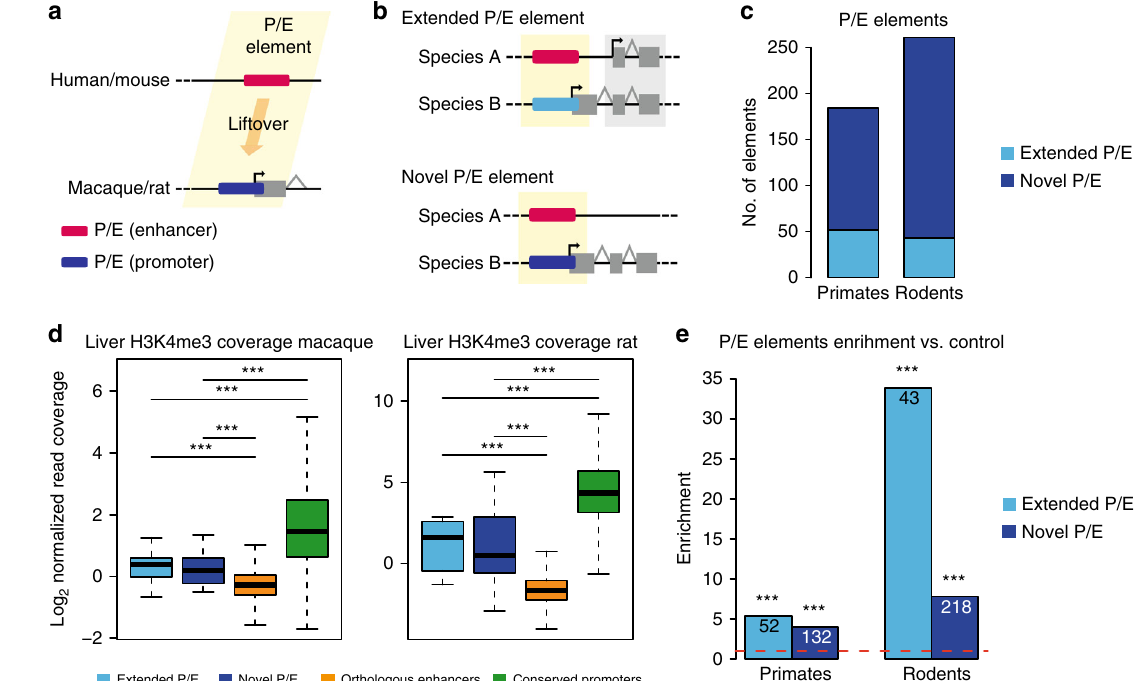
Fig. 1 Repurposing of regulatory elements in mammals. a Schematic representation of a P/E element in primates and rodents. b Types of P/E elements. c Total number of novel and extended P/E elements detected in primates and rodents. d Macaque and rat H3K4me3 ChIP-seq reads density from liver (log2 read count normalized by input read count) measured at novel and extended liver P/E elements, loci orthologous to the sister species liver enhancers and not associated to any stable TSS, and stable liver promoters conserved in the sister species. Whiskers up to 1.5 times the interquartile range; outliers removed for graphical purposes. Signi fi cant differences (Mann – Whitney U -test with Benjamini-Hochberg correction): ∗∗∗ P < 0.001. e Fold- difference between P/E elements ratio (fraction of human or mouse enhancers corresponding to promoters in sister species) and P/inactive ratio (fraction of human or mouse inactive regions corresponding to promoters). The red line indicates no difference between the two ratios. Numbers indicate the number of P/E elements for each group. Signi fi cant differences (Fisher ’ s exact test with Benjamini-Hochberg correction): ∗∗∗ P <